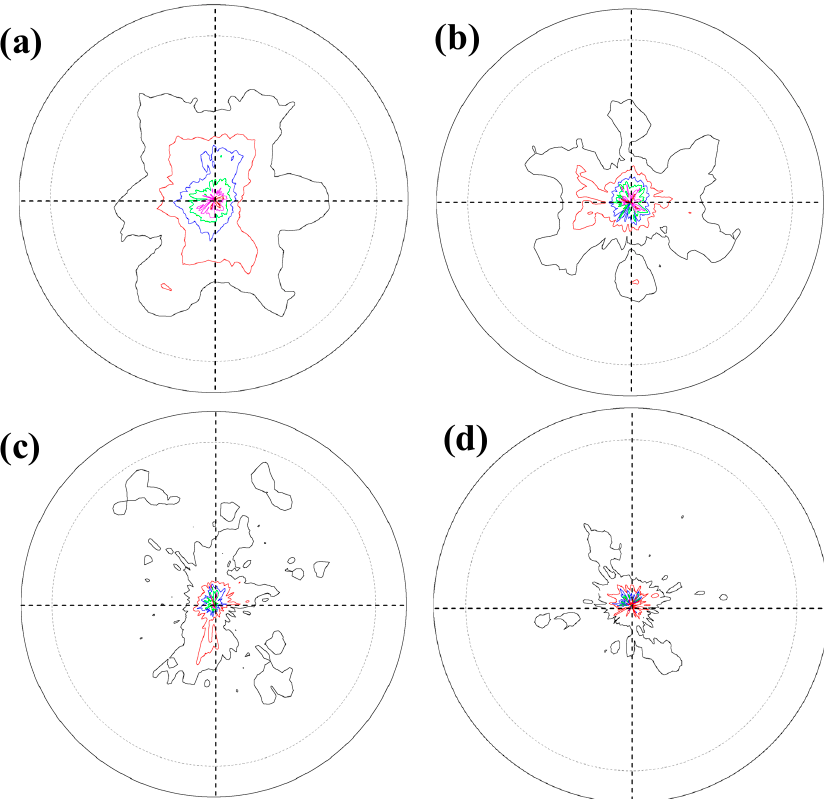
Figure 3. The {200} pole figures of four as-quenched alloys: ( a ) Alloy 1 ( b ) Alloy 2 ( c ) Alloy 3 ( d ) Alloy 4.